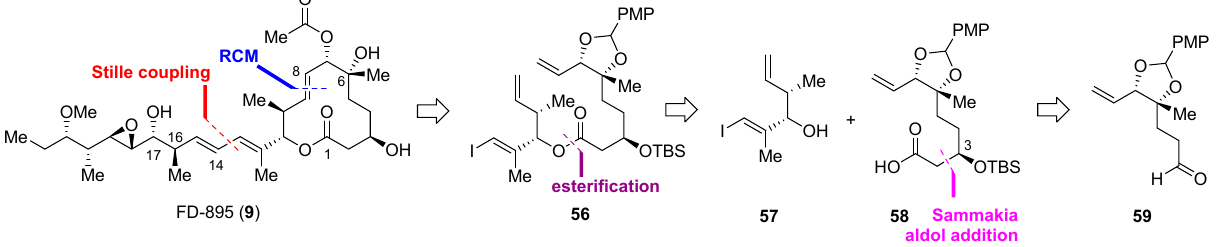
Scheme 8. Burkart’s retrosynthetic analysis of FD-895